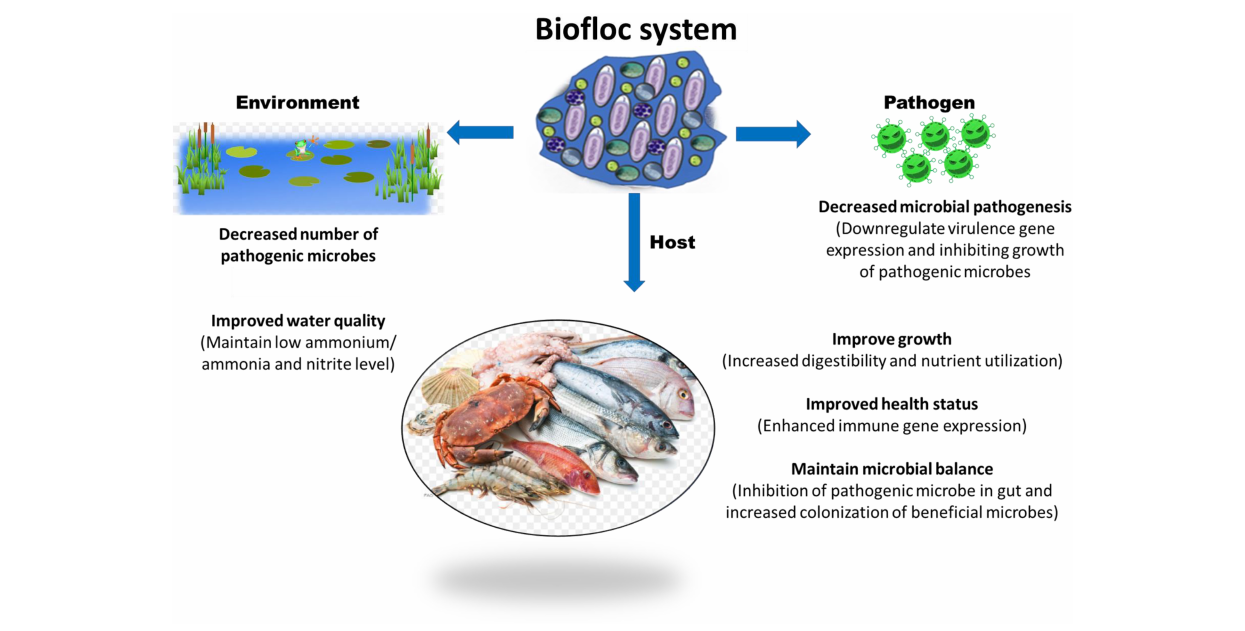
FIGURE 1 | Potential role of biofloc system in host, pathogen, and environment in a culture